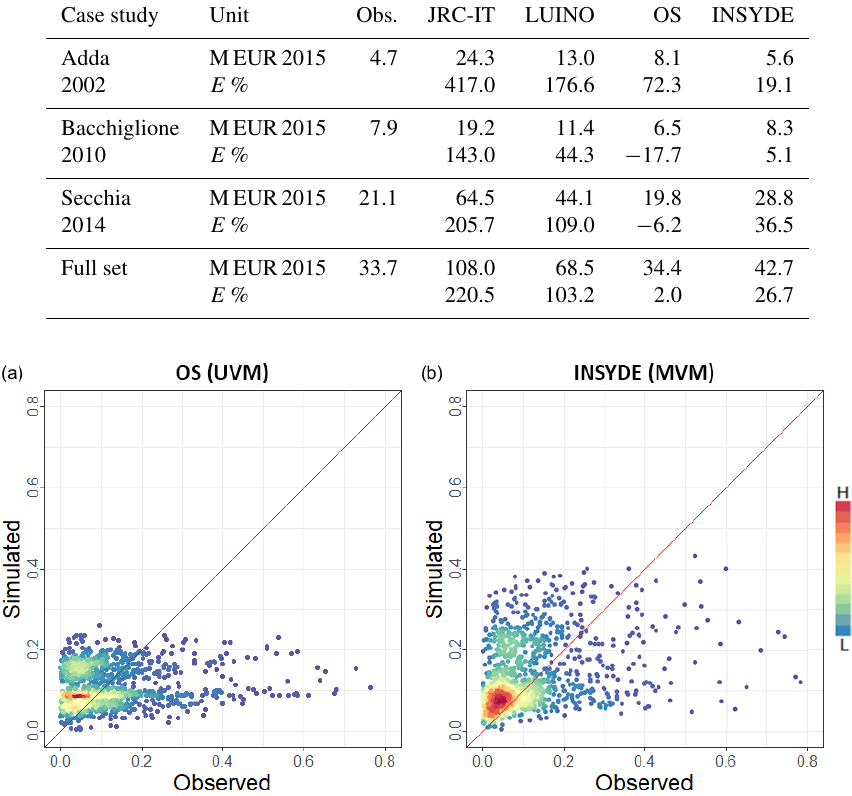
Figure 9. Scatter plot comparing relative damage estimates produced by the two best-performing literature models, OS (a) and INSYDE (b) . Simulated damage is on the y axis; observed damage is on the x axis. Colours represent record density.